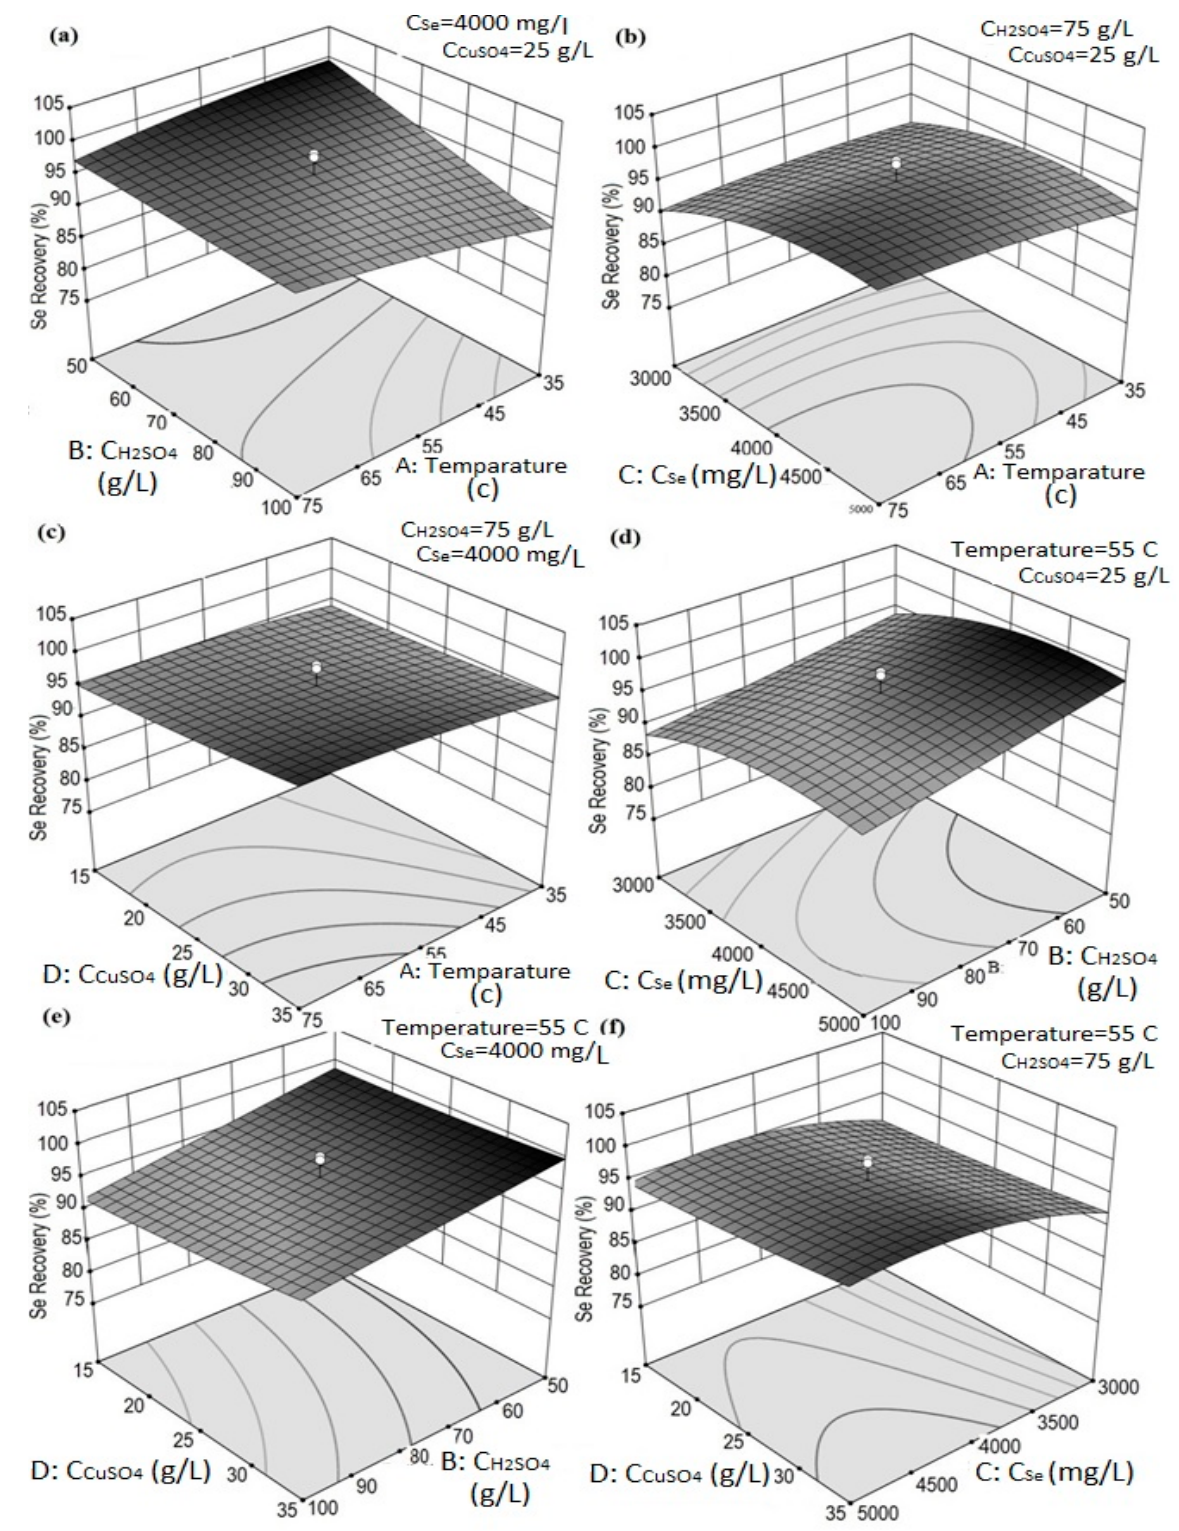
Figure 5. Response surface graphs for interactions of parameters of Se (IV) cementation by solid copper. ( a ) Effect of H 2 SO 4 concentration and temperature; ( b ) Effect of Temperature and Se concentration; ( c ) Effect of Cu concentration and temperature; ( d ) Effect of of H 2 SO 4 concentration and Se concentration; ( e ) Effect of H 2 SO 4 concentration and Cu concentration; ( f ) Effect of Se concentration and Cu concentration.